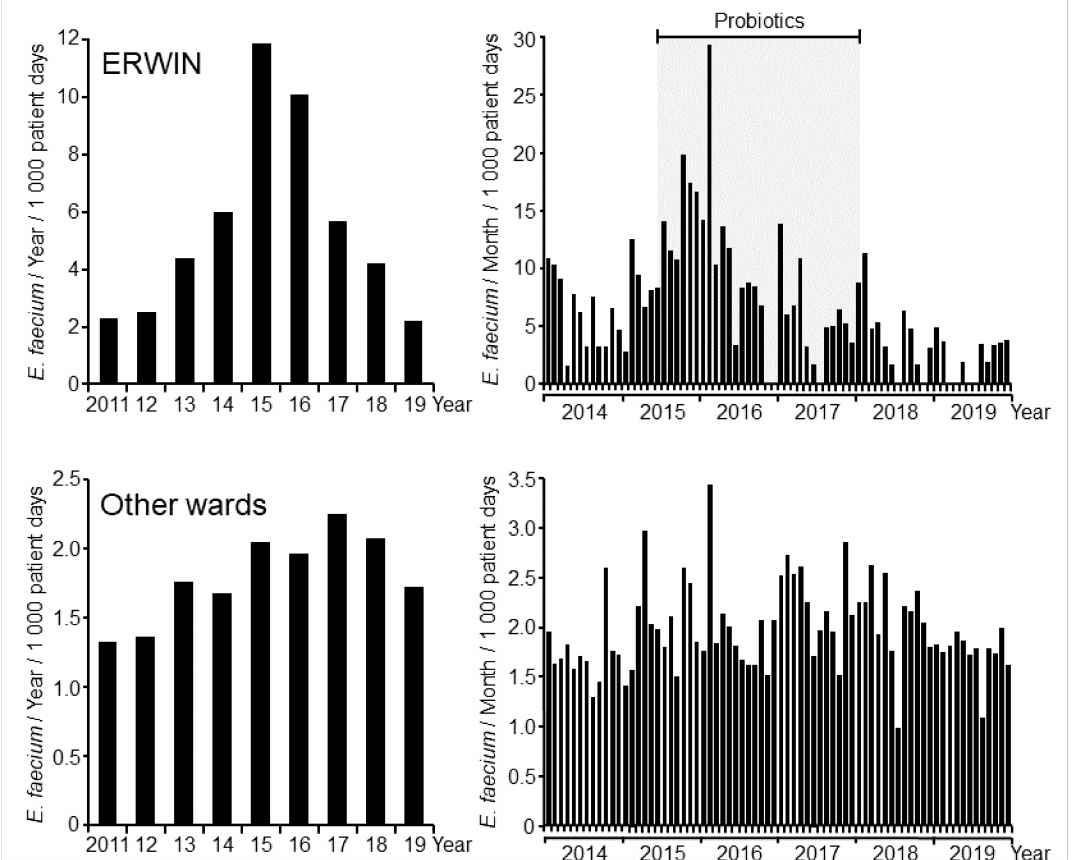
Figure 3. Number of patients colonized per 1000 patient days with vancomycin-susceptible E. faecium at Ingolstadt Hospital per year ( left panels ) and per month ( right panels ). Data were obtained from clinical samples only. Upper panels : Patients on ERWIN. Lower panels : Patients on other